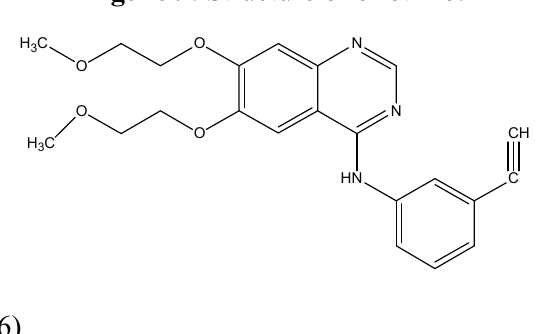
Figure 9. Structure of